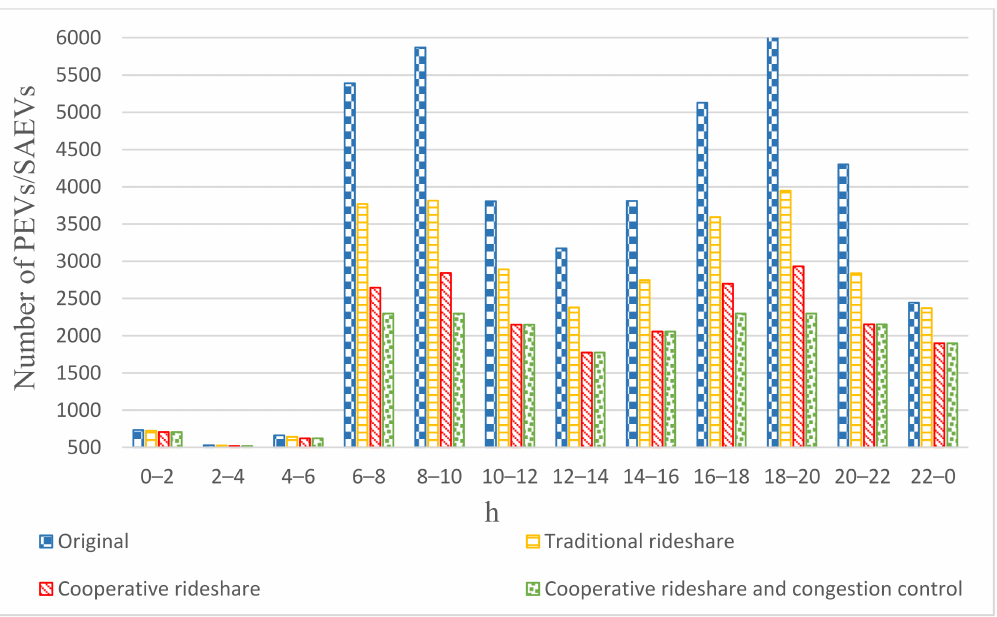
Figure 10. Traffic volumes of PEV/SAEV passengers on the major arterial road.